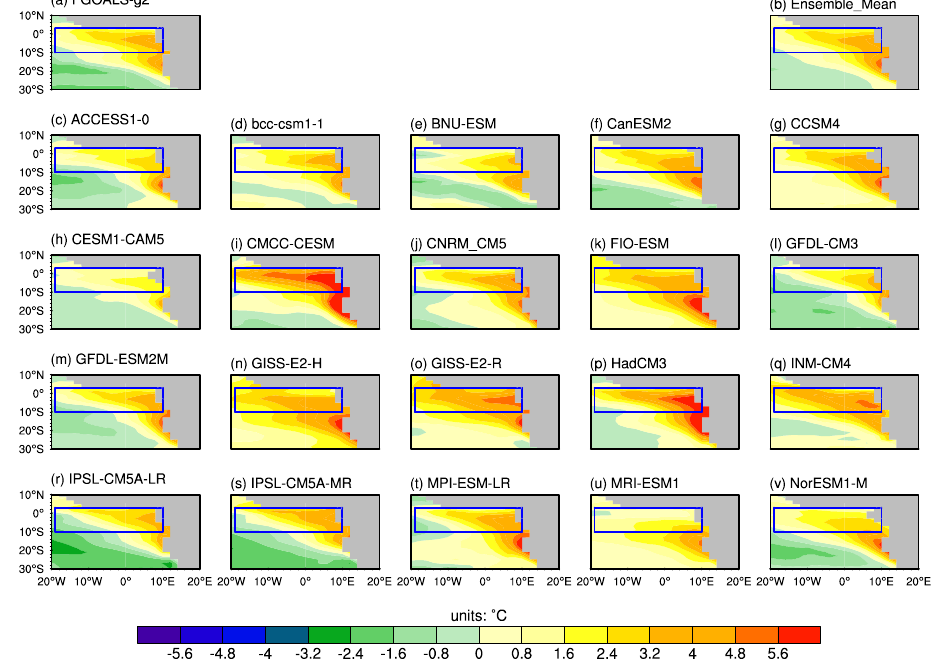
Figure 1. The seasonal mean sea surface temperature (SST; unit: °C) bias over the southern tropical Atlantic during June–August (JJA) from 1979–2005 for different coupled climate models (CCMs) of CMIP5 and their ensemble means. The blue box denotes the Atlantic Cold Tongue (ACT; 10° S–3° N, 20° W–10° E) region.